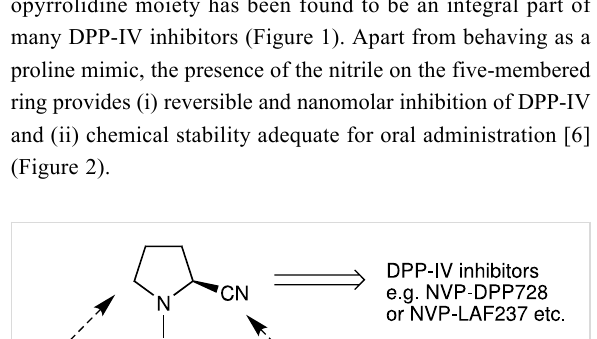
Chemically, incorporation of a 2( S )-cyanopyrrolidine moiety